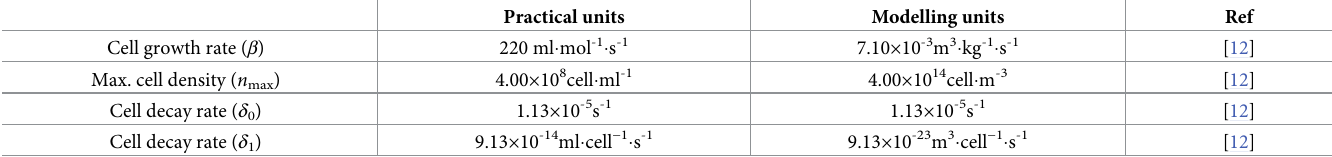
Table 3. Cell density dynamics parameters.